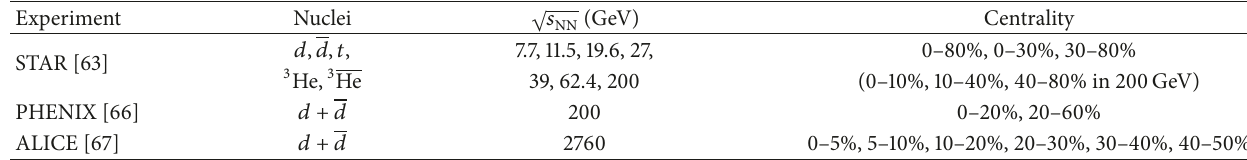
Table 1: Available measurements of light nuclei V 2